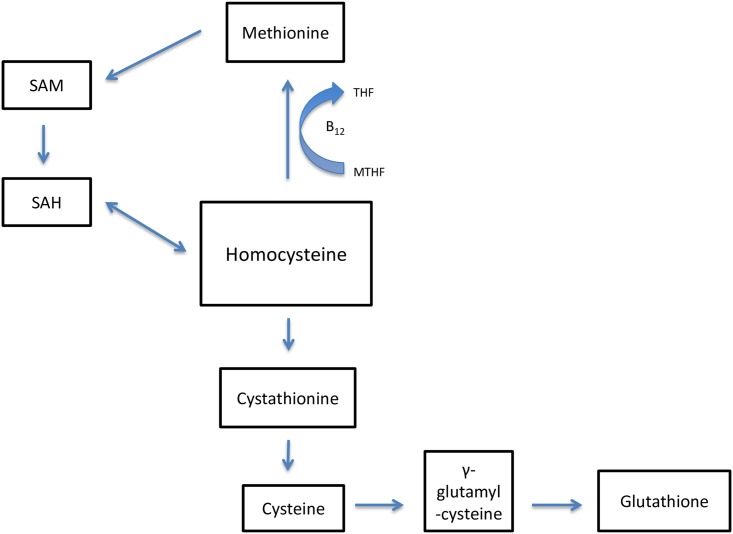
Homocysteine metabolism.Abbreviations: SAM, S-adenosyl-methionine; SAH, S-adenosyl-homocysteine; MTHF, methylenetetrahydrofolate; THF, tetrahydrofolate.